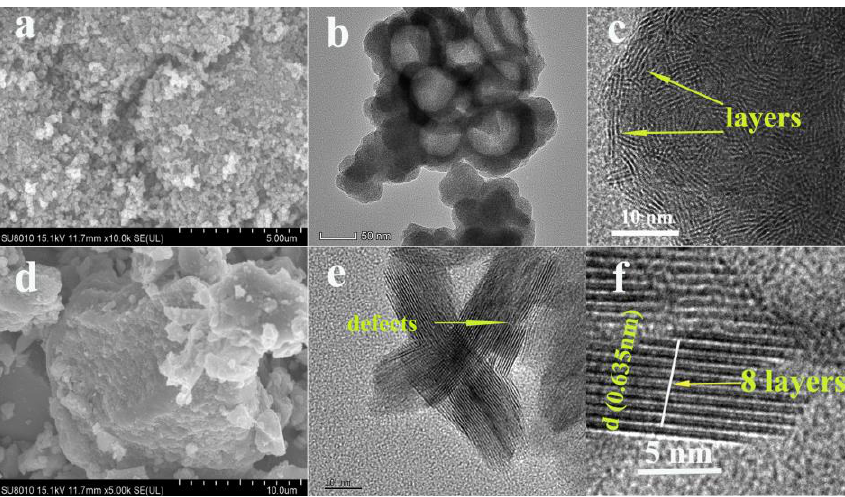
Figure 2. SEM ( a , d ) and TEM ( b , c , e , f ) images of the spherical MoS 2 and lamellar MoS 2 .